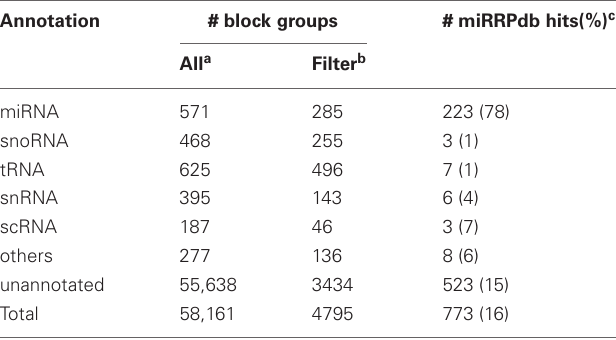
Table 4 | Annotation status of 58,161 block groups obtained after preprocessing of ENCODE dataset and their alignment to